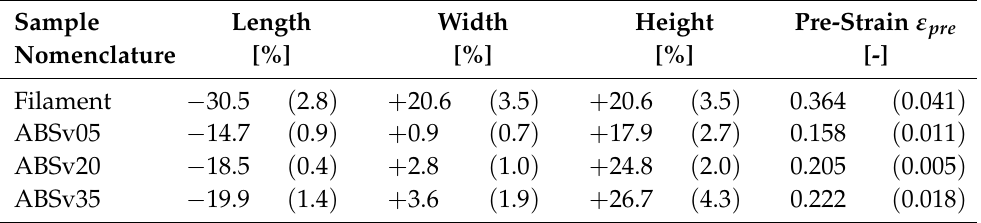
Table 5. Average dimensional changes of ME-AM sample sets after a thermal treatment at 130 ◦ C for over six hours. Expansion: + ; Contraction: − . Standard deviations are indicated between